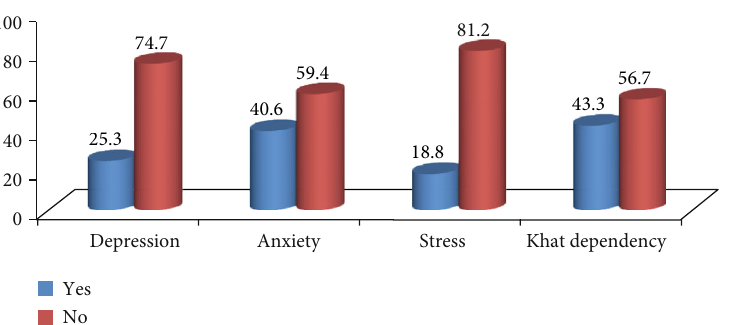
Figure 1: Prevalence of depression, anxiety, stress, and dependency among khat chewers in Amhara region,